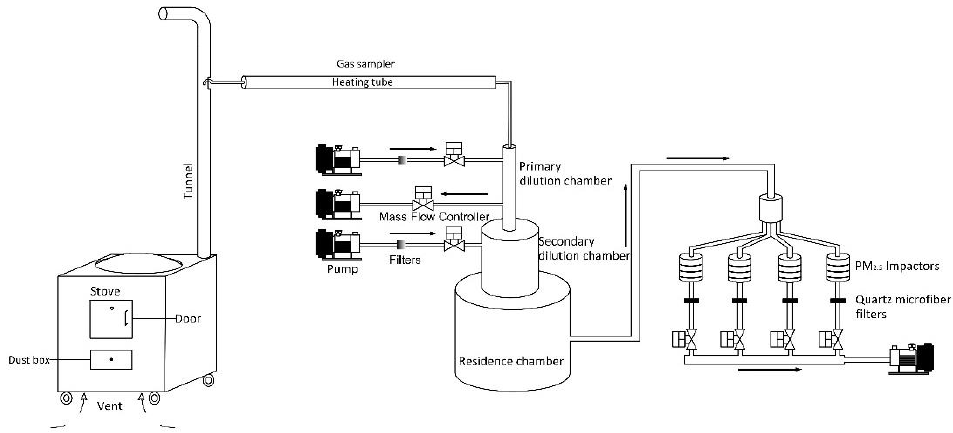
Figure 2. Sketch of the diluting and sampling